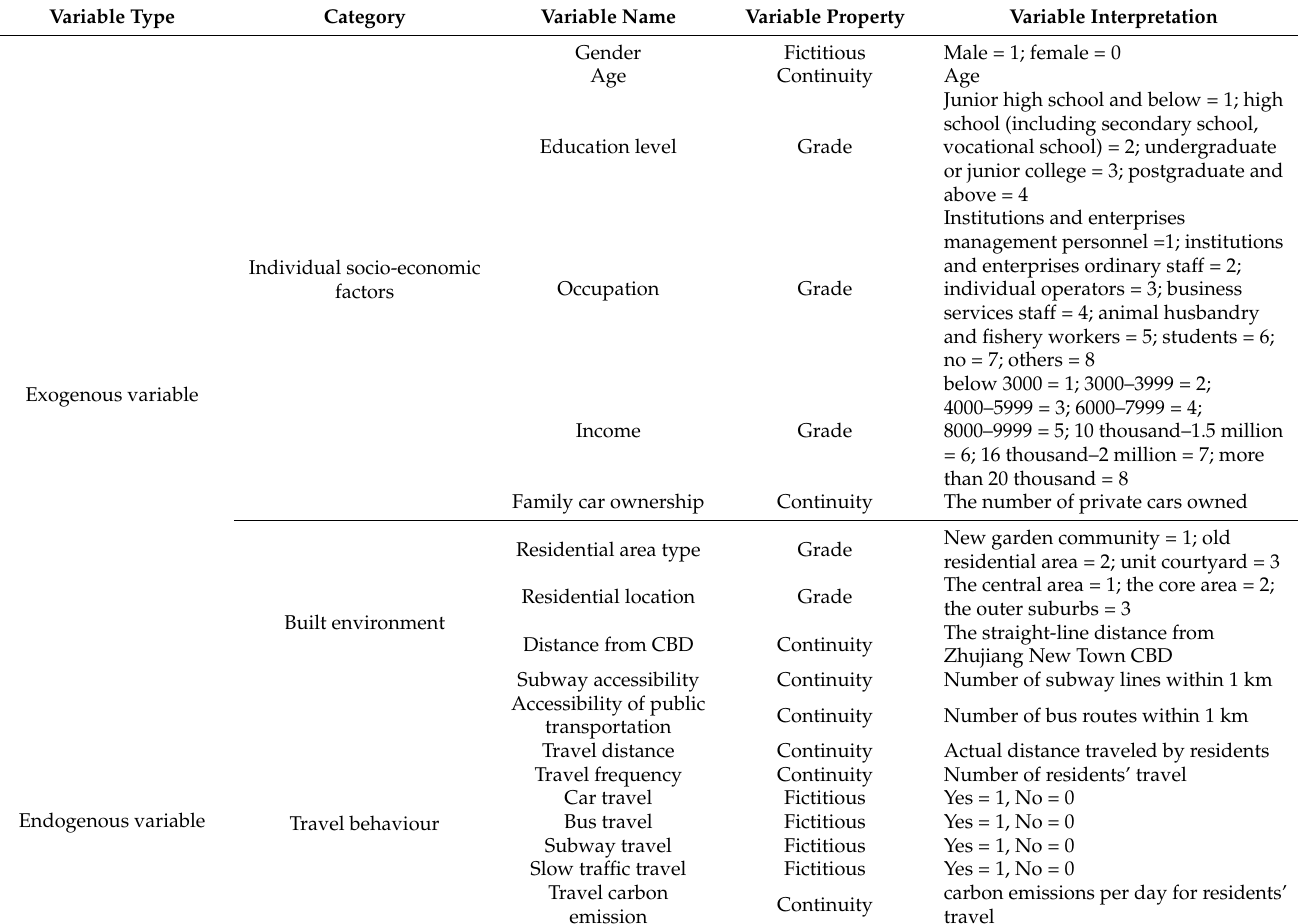
Table 4. Processing and interpretation of variables.